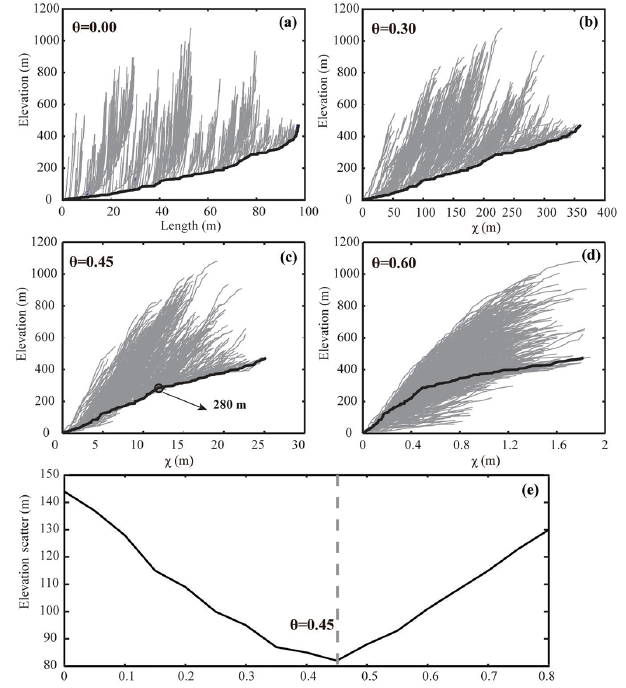
Figure 18. Concavity values that maximize the co-linearity of the main stem with its tributaries. (a–d) The χ − z plots of the stem (black line) and its tributaries (gray lines) using different values of θ ( A cr = 0.1km 2 , and A 0 = 1m 2 ). (e) The elevation scatter of the χ − z plots showing that minimum scatter is achieved with θ = 0.45.